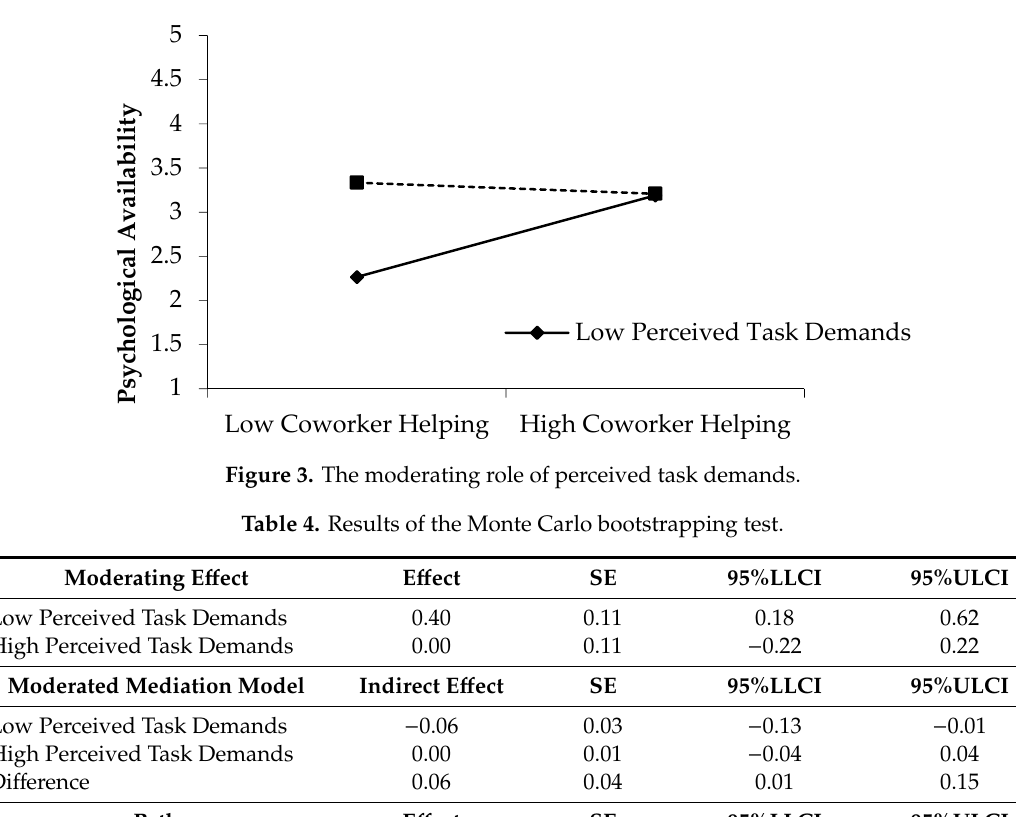
Table 4. Results of the Monte Carlo bootstrapping test.